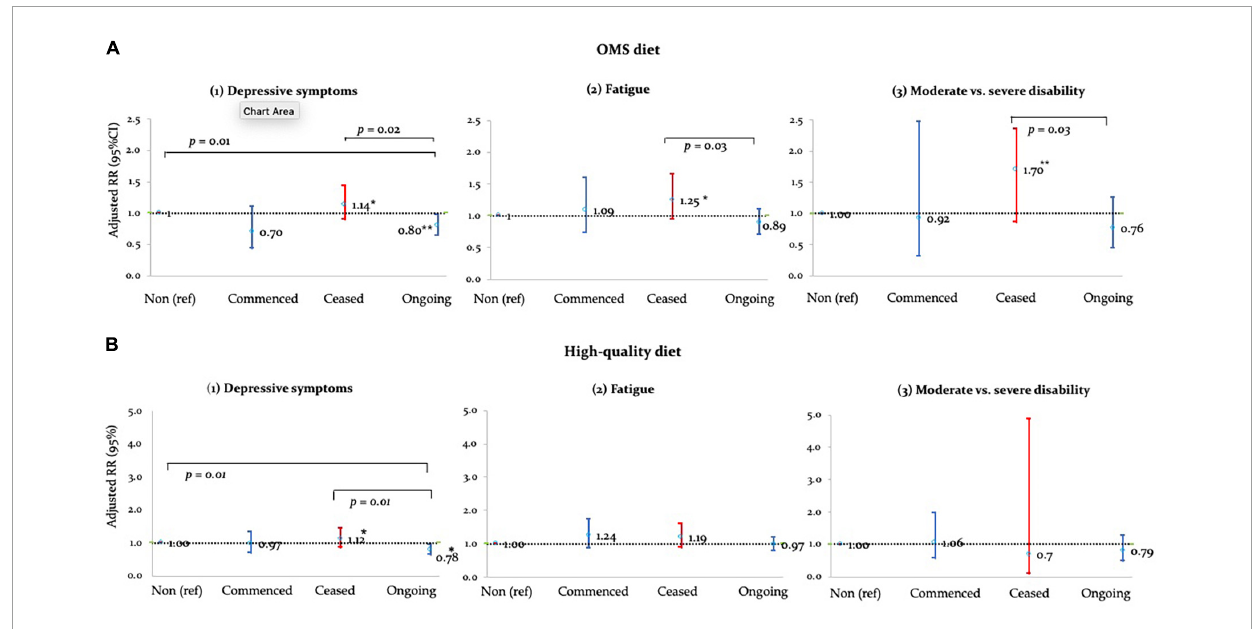
FIGURE1 Adjusted RRs of (A) OMS- and (B) high-quality diet adherence vs. health outcomes. * p < 0.05; ** p < 0.01.